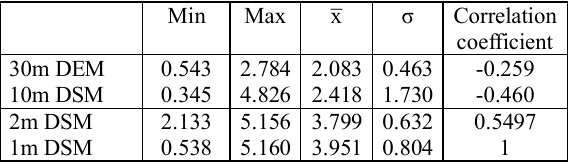
Table 3. Descriptive statistics of the comparisons of the solar radiation model for Alaska